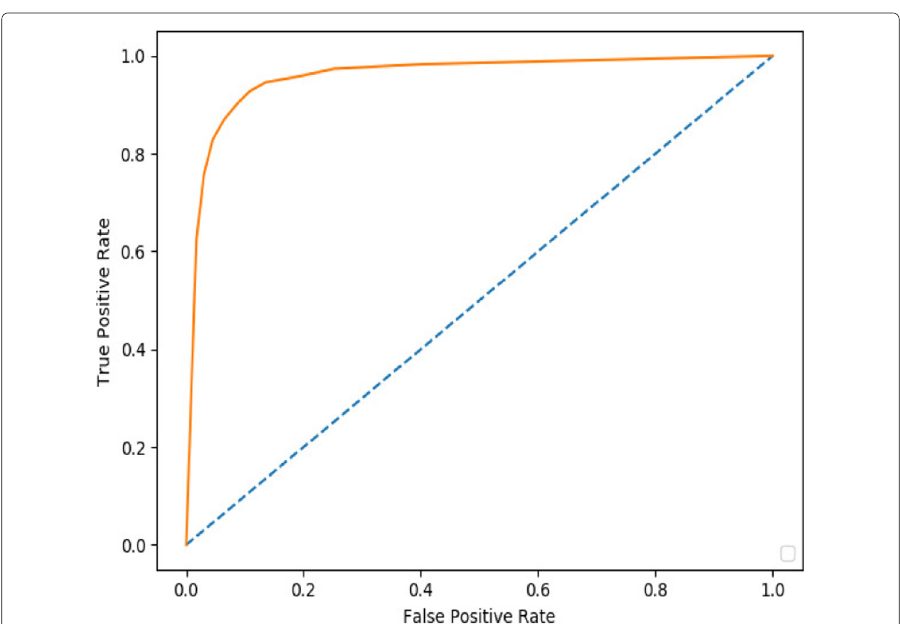
Fig. 5 The ROC curve of improved ZOE method